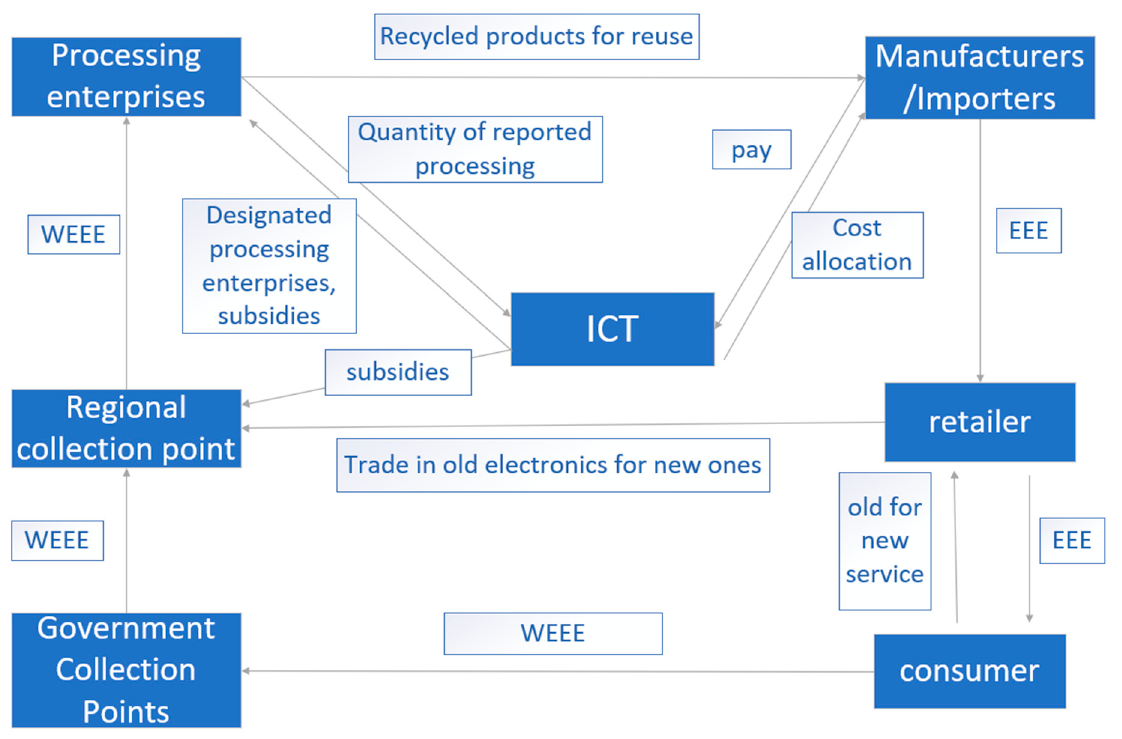
Figure 3. Operation model of the Dutch information technology and telecommunications (ICT) waste electrical and electronic equipment (WEEE) fund system (concluded from [18,33]).